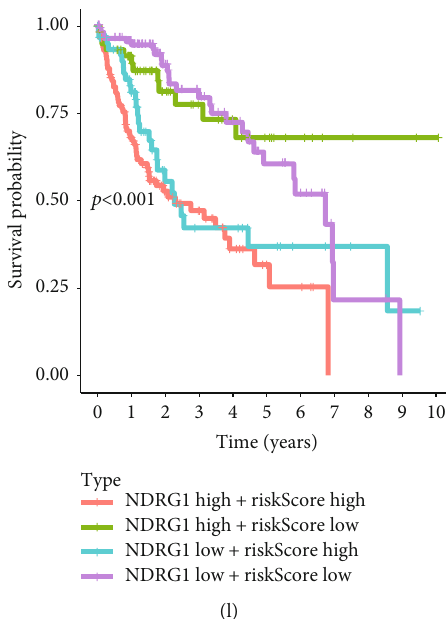
Figure 7: Survival analysis of HCC patients based on the risk score and several hypoxia-related genes. (a) Expression pro fi les of several hypoxia-related genes in high-risk and low-risk groups. (b – l) Two-factor survival analyses of risk score and immune checkpoint molecules including SLC2A1 (b), LDHA (c), ALDOA (d), ENO1 (e), VEGFA (f), ACOT7 (g), TPI1 (h), CDKN3 (i), MRPS17 (j), MIF (k), and NDRG1